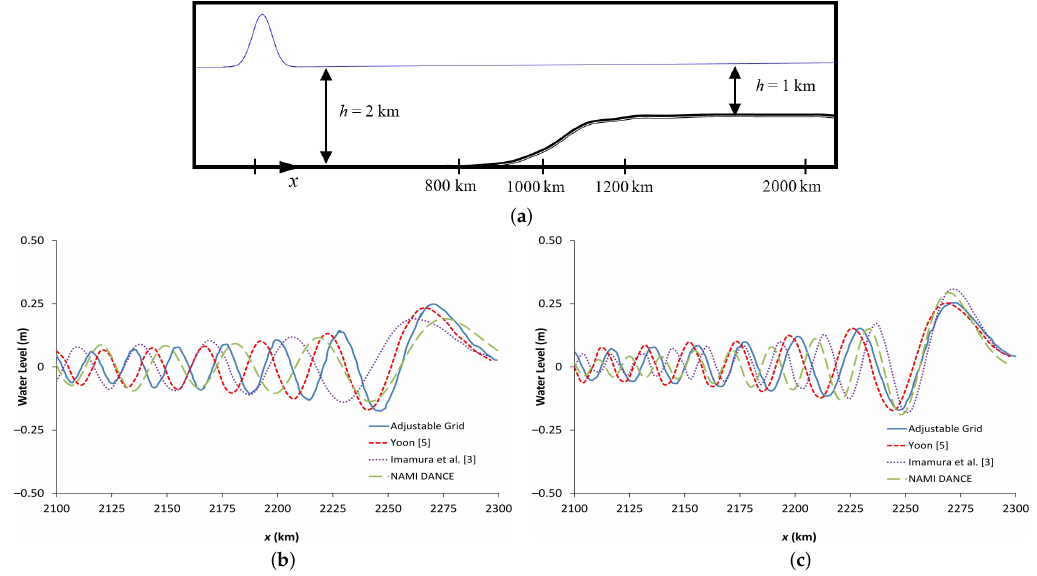
Figure 5. ( a ) Schematic representation of Gaussian hump propagating over a slowly varying topography [5]. Water surface profiles comparison of several methods at t = 40,000 s and h = 1 km for two different grid sizes ( b ) ∆ x = 4 km and ( c ) ∆ x = 2